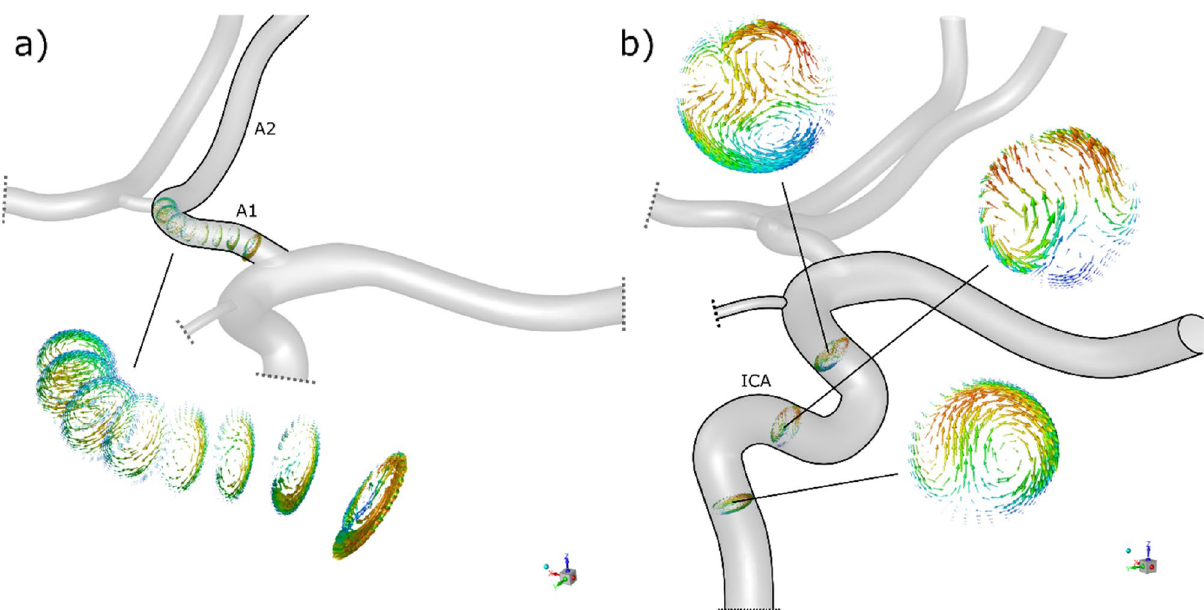
Figure 5. Velocity vectors in planes perpendicular to the axis of the arteries represent secondary flows due to ( a ) rapid change of flow direction and ( b ) vessel